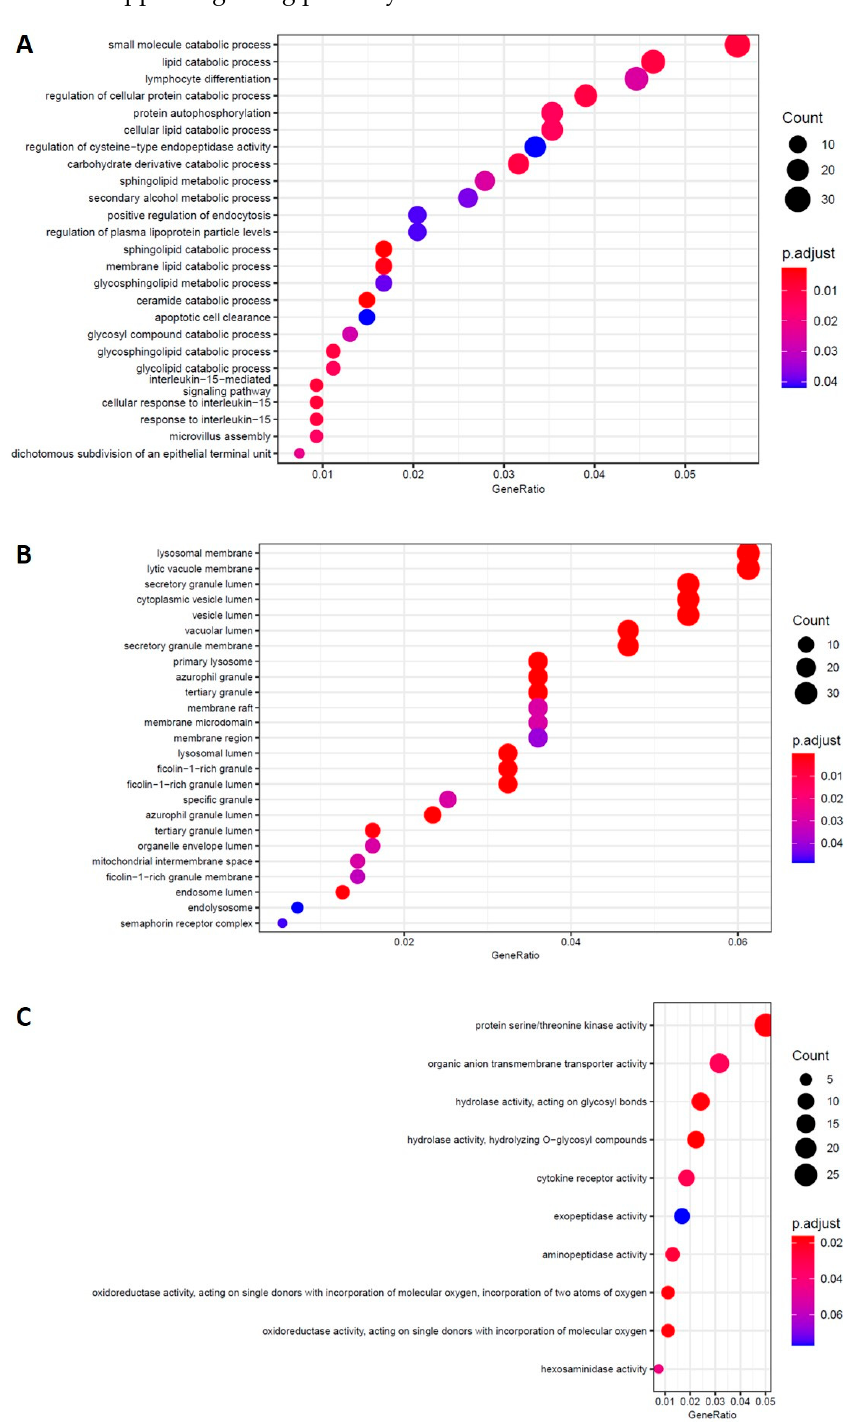
Figure 7. AD vs. CTR. GO-enriched terms for the biological process ( A ), cellular component ( B ), and molecular function ( C ).